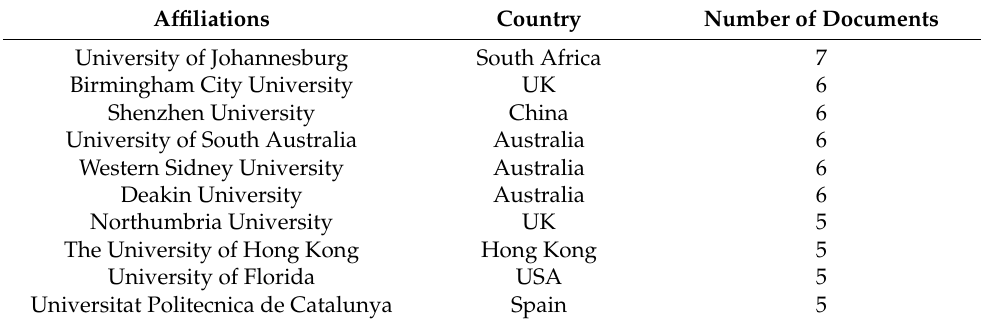
Table 11. Most relevant affiliations analysis performed with Biblioshiny version 4.0.